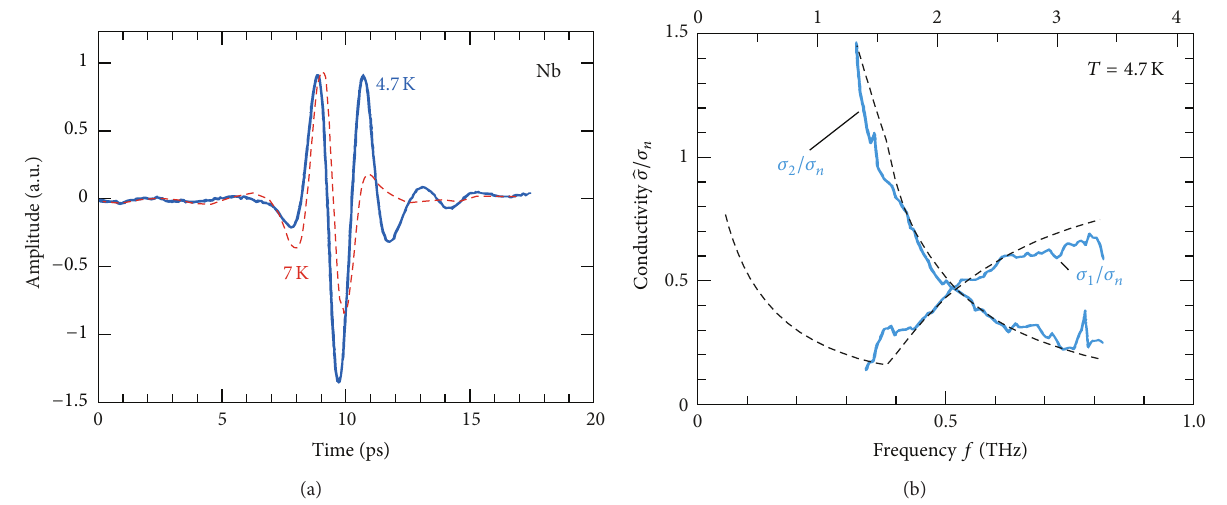
Figure 13: (a) THz transients transmitted through a thin niobium film ( 𝑇 𝑐 = 6.25 K) on quartz in the normal state (dashed red line) and the superconducting state (solid blue line). (b) Real and imaginary parts of the normalized complex conductivity, 𝜎 1 (𝜔) and 𝜎 2 (𝜔) , of Nb in the superconducting state evaluated from the above data (after [96]). The dashed black line indicates the predictions by the BCS theory using the Mattis-Bardeen equations (1) and (2). The energy gap is given by 2Δ(0) = 3.8𝑘 𝐵 𝑇 𝑐 .